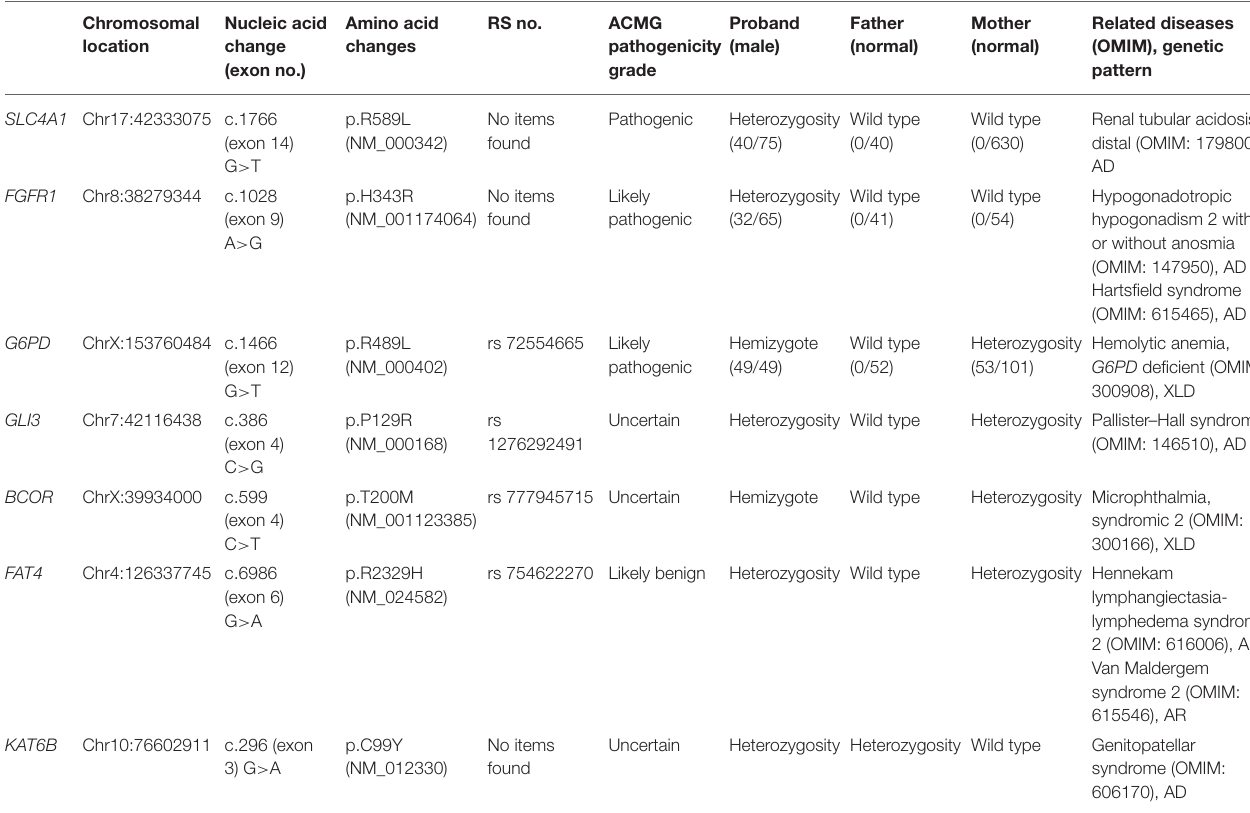
TABLE 3 | Results of exome sequencing.